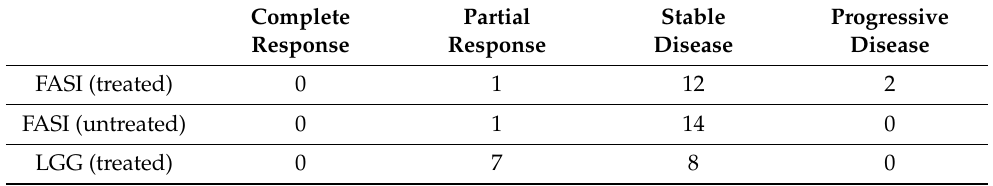
Figure 4. T2 weighted MR imaging of a typical LGG and FASI at four time points during treatment. ( A ) The measured FASI in the right medial cerebellum (arrow) stayed relatively stable during the treatment course. ( B ) The presumed low ‐ grade glioma involving the splenium of the corpus collo ‐ sum (arrowhead) decreased substantially from the baseline over the treatment course. Table 2. Response criteria at paired time points for FASI with and without treatment and treated LGG.